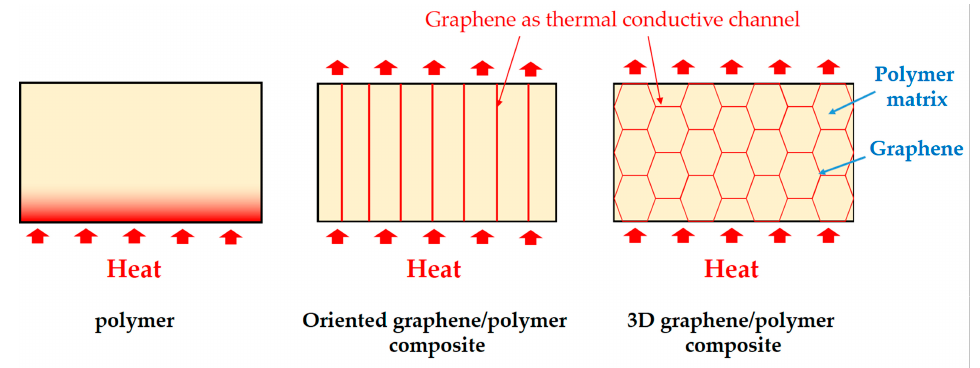
Figure 6. Schematic of thermal conductance in a polymer, oriented graphene/polymer composite, and 3D graphene/polymer